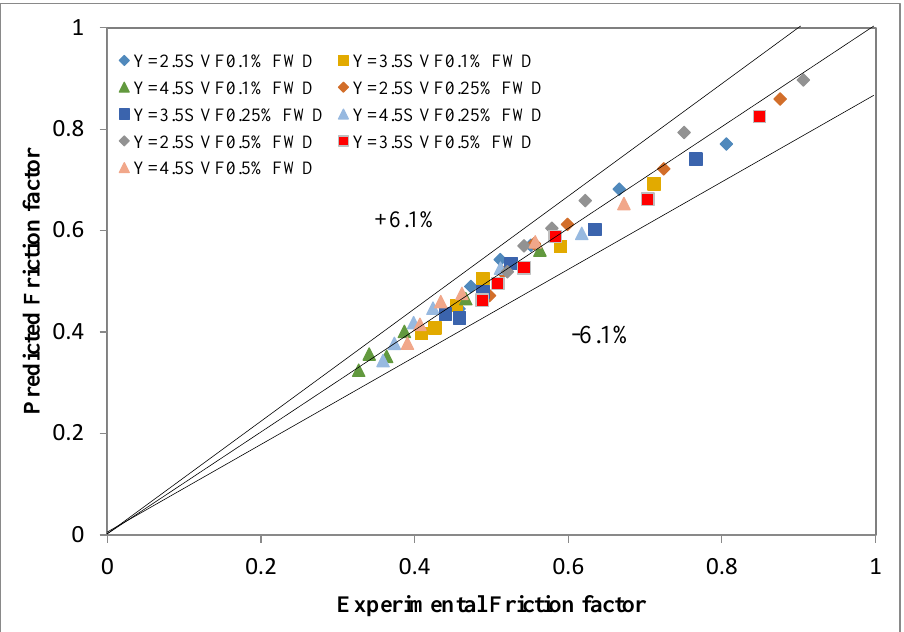
Figure 18. Predicted versus experimental friction factor for a staggered conical strip insert with the